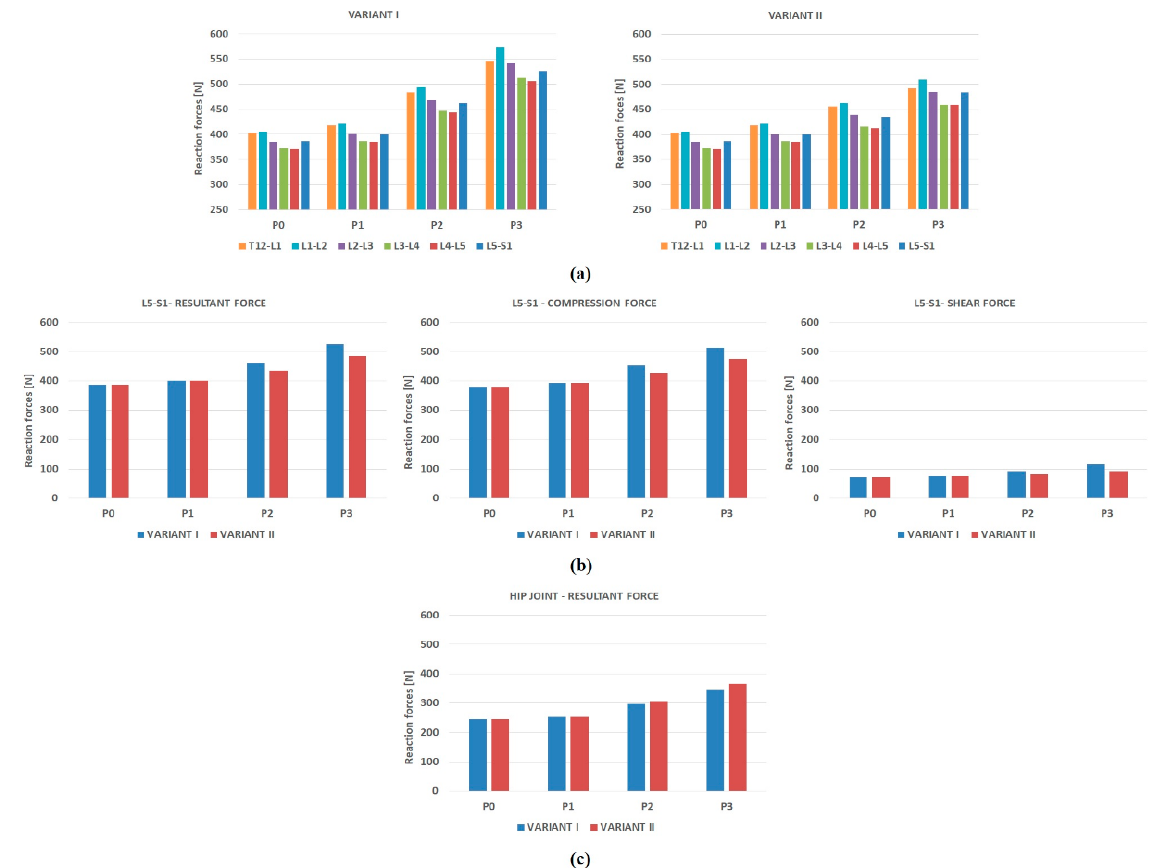
Figure 3. Values of loads in the musculoskeletal system generated within the lumbopelvic complex: ( a ) resultant forces in lumbar segments, ( b ) resultant, compression and shear force in segment L5-S1, ( c ) resultant force in the hip joint.